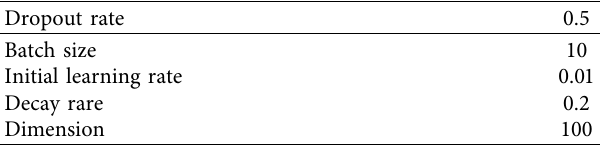
Table 2: Hyperparameter